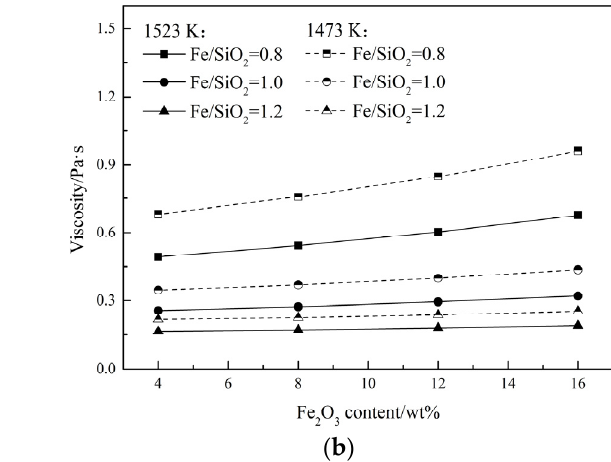
Figure 12. FTIR results with various Fe 2 O 3 content in the FeO − X wt%Fe 2 O 3 − SiO 2 − 8 wt%CaO − 3 wt%MgO − 3 wt%Al 2 O 3 melts at Fe/SiO 2 of ( a ) 0.8 and ( b ) 1.2.